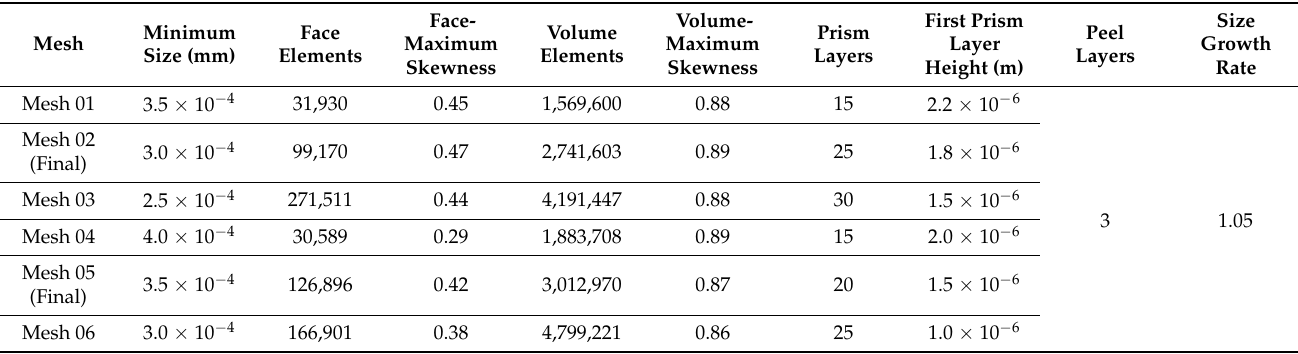
Figure 2. Mesh independence tests for the two CA models: ( a ) ICASA−1 and ( b ) ICASA−2. Table 1. Mesh details in mesh independence tests for ICASA models.